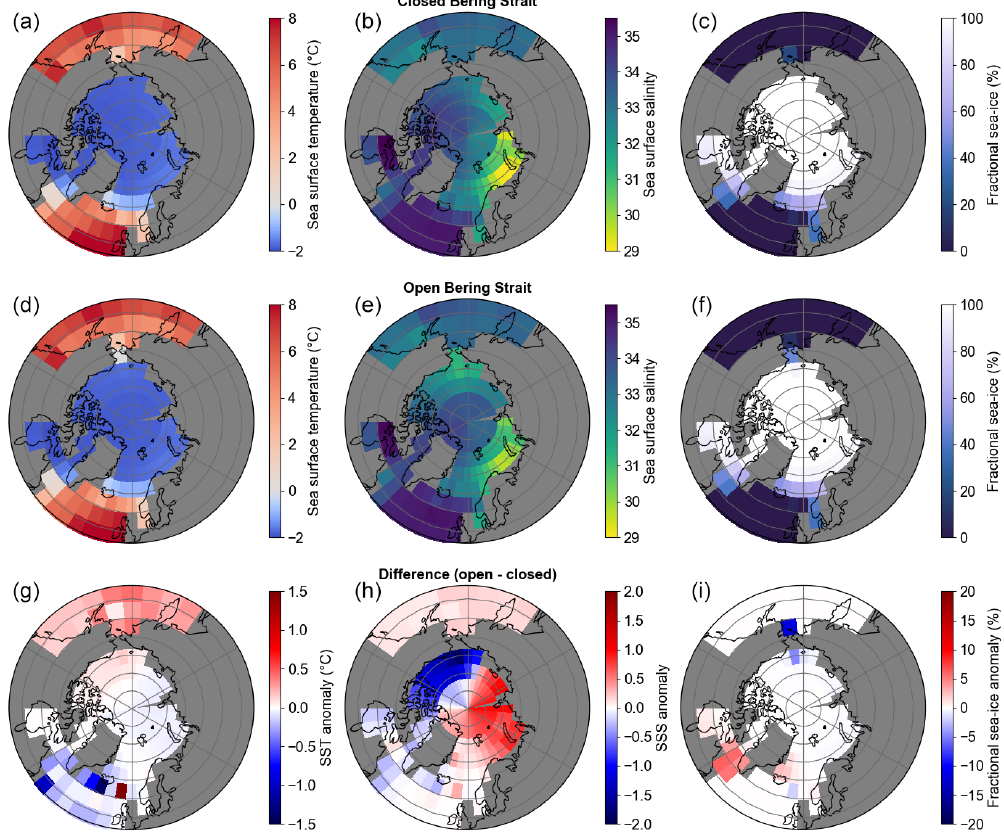
Figure B7. Annual mean sea surface temperature (SST), sea surface salinity (SSS), and fractional sea ice north of 50 ◦ N under LGM boundary conditions. (a, b, c) Closed Bering Strait (simulation LGM_BS + wind + tidal), (d, e, f) the new steady state after transiently opening the Bering Strait but all other boundary conditions as in the top row, and (g, h, i) the difference between open and closed Bering